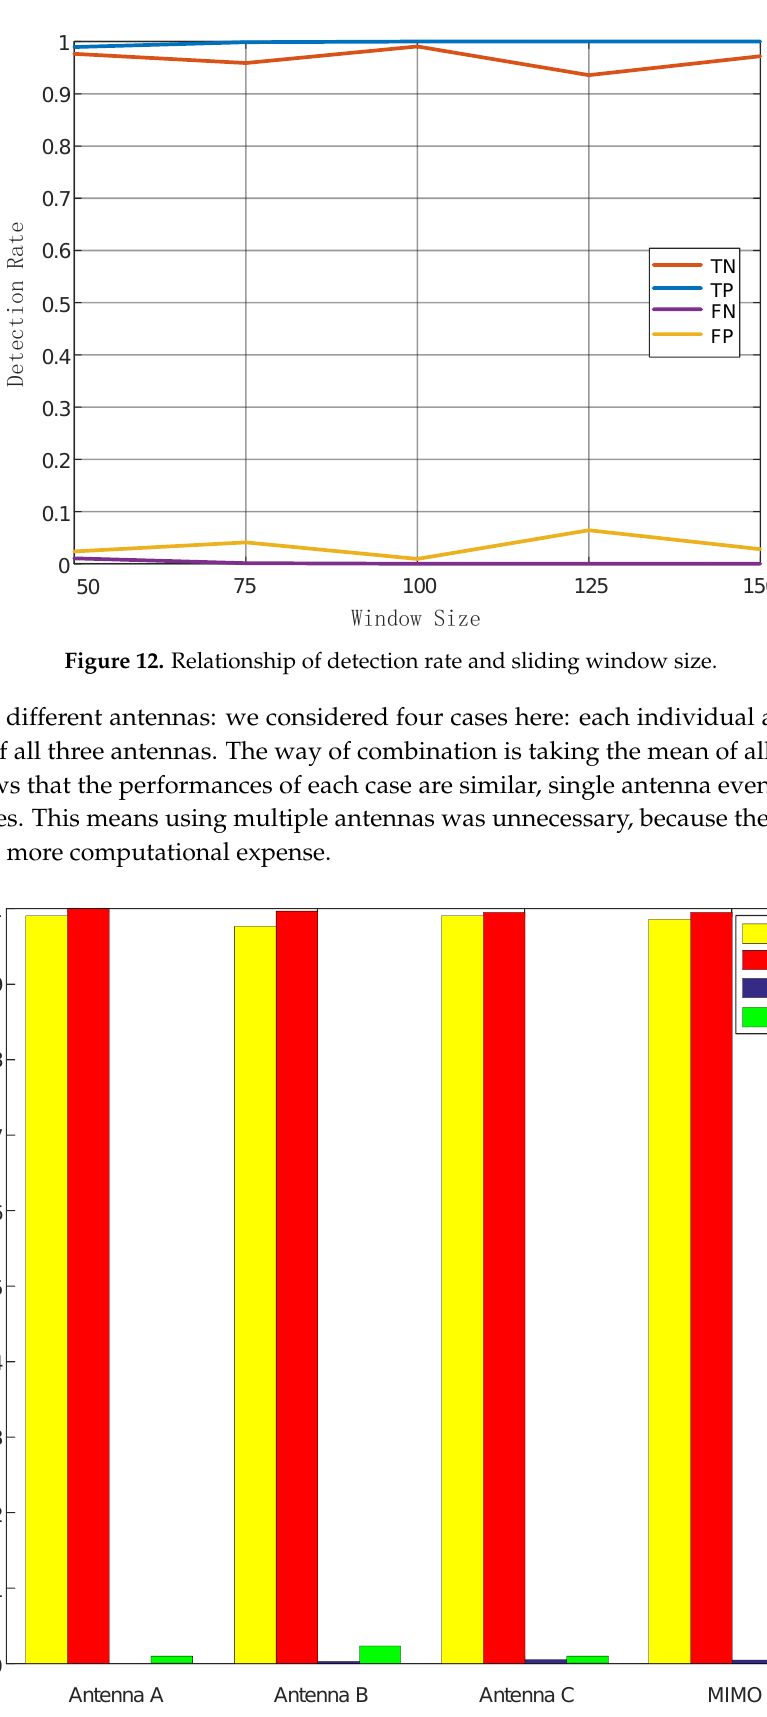
Figure 13. Relationship between detection rate and different